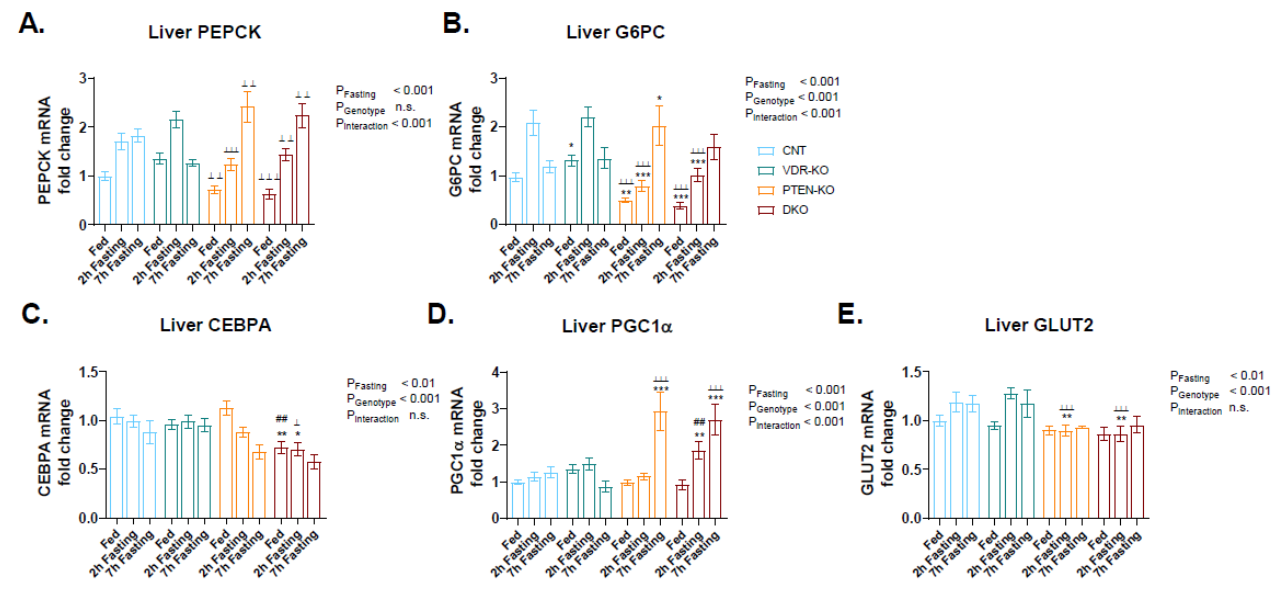
Figure 4. Expression of genes involved in glycogen metabolism in liver. mRNA expression of ( A ) Phosphoenolpyruvate carboxykinase (PEPCK), ( B ) Glucose-6-phosphatase (G6PC), ( C ) CCAAT/enhancer-binding protein alpha (CEBPA), ( D ) Peroxisome proliferator-activated receptor gamma coactivator 1-alpha (PGC1α ) and ( E ) Glucose transporter 2 (GLUT2) using TATA-binding protein (TBP) as the housekeeping gene. Data are represented as mean ± SEM. * p < 0.05 vs. CNT; ** p < 0.01 vs. CNT; *** p < 0.001 vs. CNT; ⊥ p < 0.05 vs. VDR-KO; ⊥⊥ p < 0.01 vs. VDR-KO; VDR-KO; ⊥⊥⊥ p < 0.001 vs. VDR-KO; ## p < 0.01 vs. PTEN-KO. CNT: Control. VDR-KO: Vitamin D receptor knockout. PTEN-KO: Phosphatase and tensin homolog knockout. DKO: Double knockout.